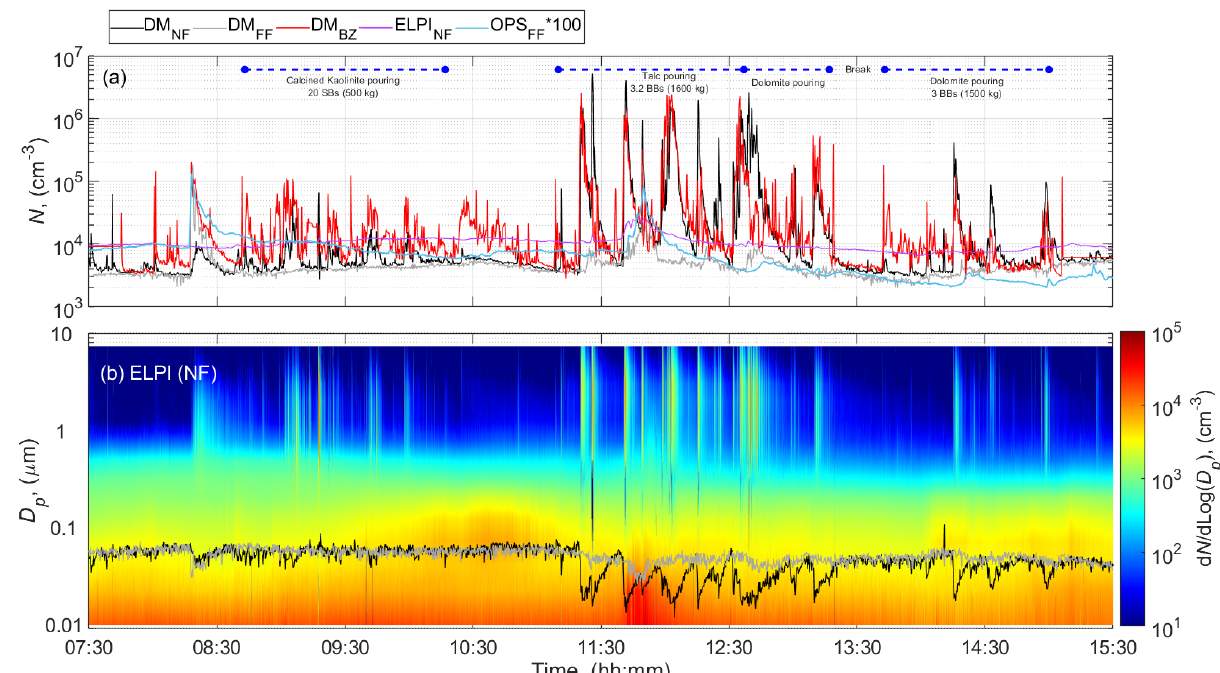
Figure 3. Time series during pouring activities involved in the paint formulation of batch #2 at the PS of ( a ) total particle number concentration, and ( b ) particle number size distributions measured by ELPI at NF and mean particle size diameter measured by DM at NF and FF. The blue horizontal lines show the filter sampling periods.